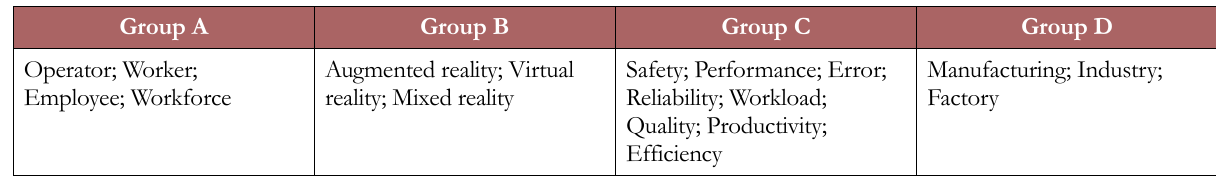
Table 1. List of keywords selected for the systematic